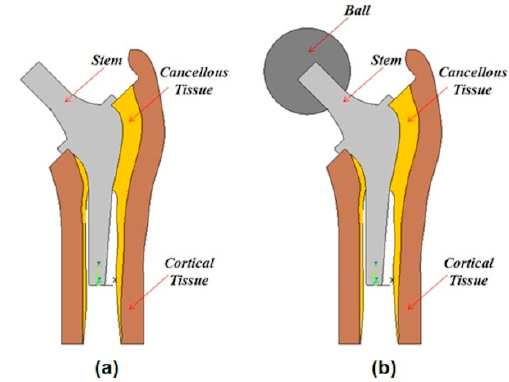
Figure 1. Illustration of the different parts of the hip prosthesis: ( a ) The previous model [1], and ( b ) the newly proposed model.